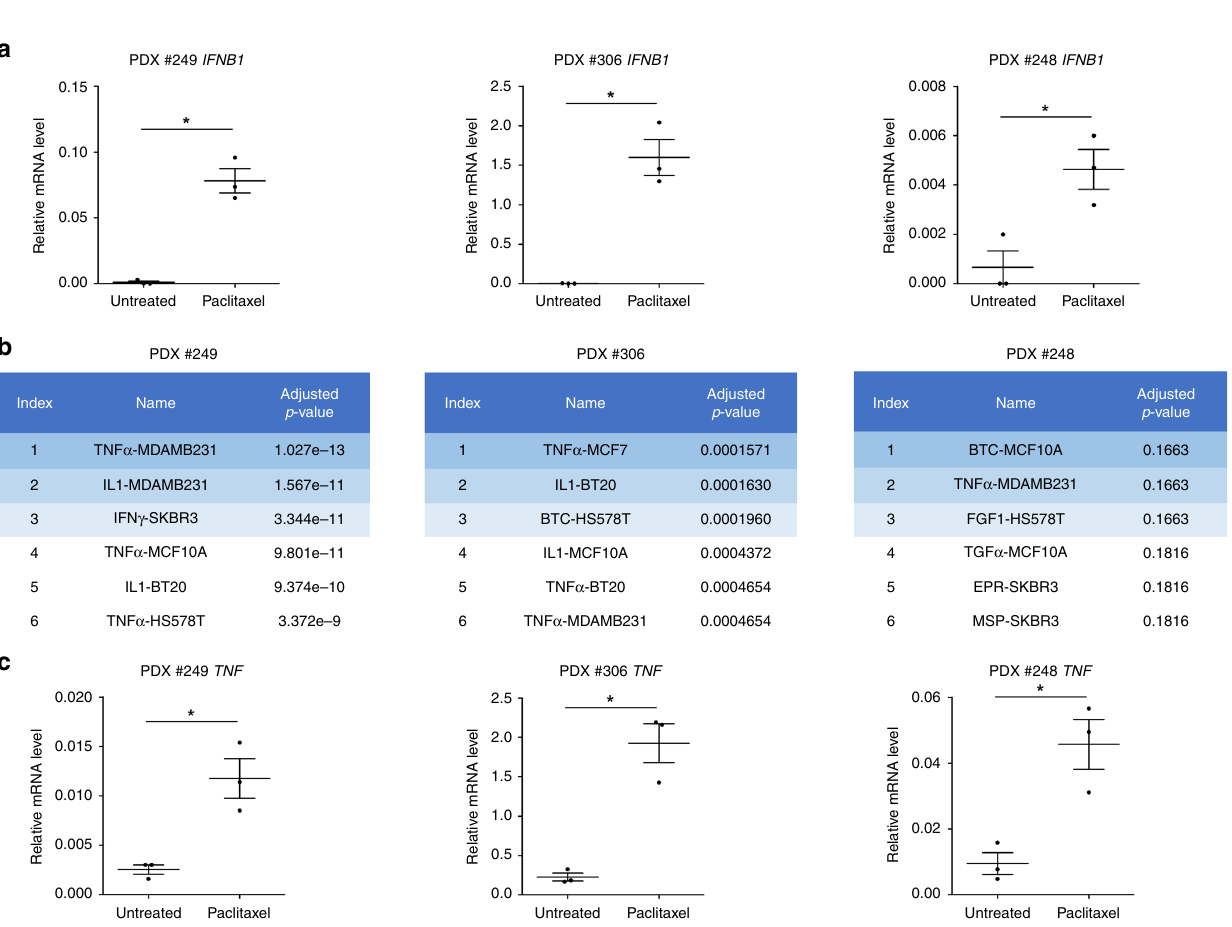
Fig. 3 Paclitaxel-treated cancer cells activate type I IFN and TNF α through the cGAS/STING pathway. a IFNB1 qPCR analysis in PDX treated or not by paclitaxel. b Global transcriptomic analysis in paclitaxel-treated PDX compared to untreated PDX using Enrichr omic tool LINCS L1000 Ligand Perturbations up. c TNF qPCR analysis in paclitaxel-treated or untreated PDX. n = 3 mice per group, Error bars indicate mean + / − SEM; Two-sided paired t -test. The symbols correspond to a p -value inferior to